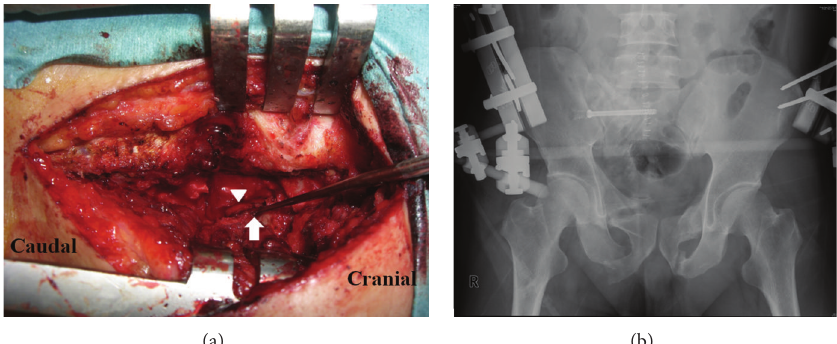
Figure 3: (a) Intraoperative photograph illustrating the exposure of the nonunion site. Arrowhead shows S1 nerve root. Arrow shows the nonunion site. (b) Postoperative anteroposterior radiograph.